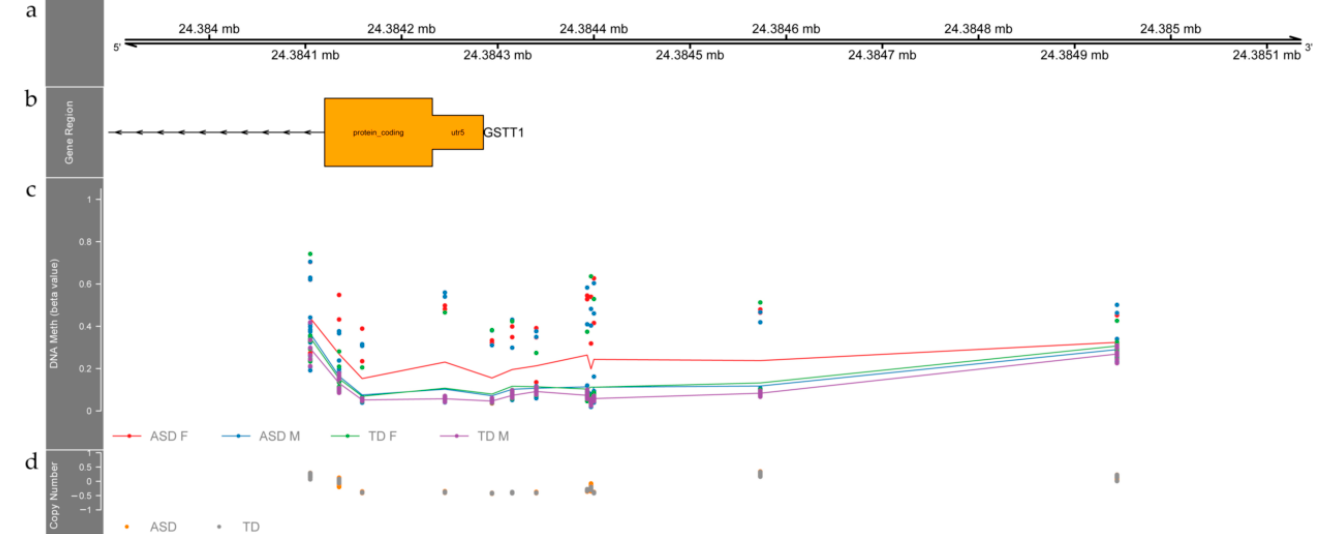
Figure 3. A genome-wide differentially methylated region (DMR) located in the 5 (cid:48) UTR region of the GSTT1 gene is hypermethylated in buccal cell tissue from autistic individuals. ( a ) Upper panel depicts coordinates in chromosome 12 (hg19). ( b ) Represents the corresponding annotation data according to the BioMart database. ( c ) Methylation data are shown as beta values, smoothed lines denote mean methylation levels for female ASD (red), male ASD (blue) and typically developing males (purple) and females (green). Each point represents the methylation level of a particular individual at a specific genomic location. ( d ) Copy number estimate obtained by calculating the difference between total probe intensity for a given individual and the mean total intensity across all individuals for a given probe. ASD subjects in orange, TD in